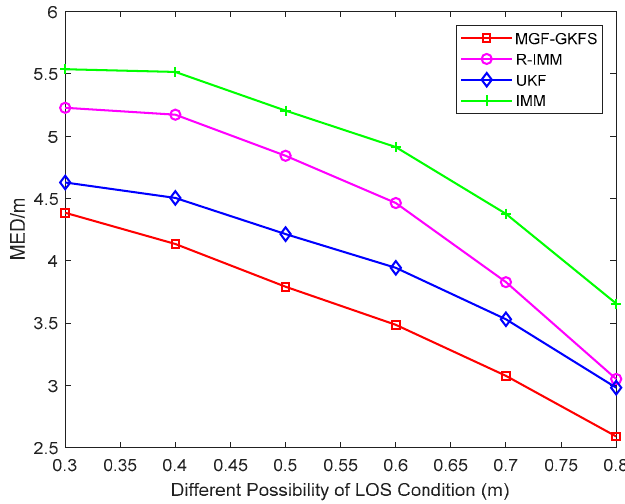
Figure 11. The MED versus di ff erent possibility of LOS condition.